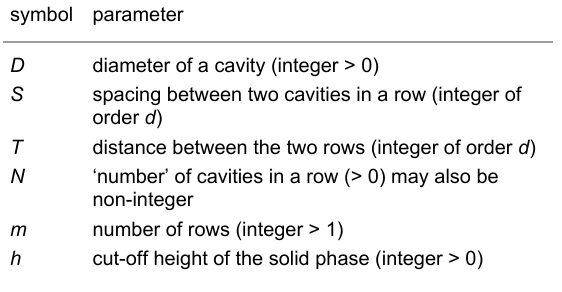
Table 1: Parameters that determine the structure of the inverse opal. Even and odd rows of cavities are displaced by half the distance be- tween the cavities in a row, that is, by s /2. All quantities are given in lattice units, that is in values of b . Below also the cut-off ratio c = h / d (to specify which part of the cavity is cut-off) and Φ S (the fraction of the top of the surface that is solid) is